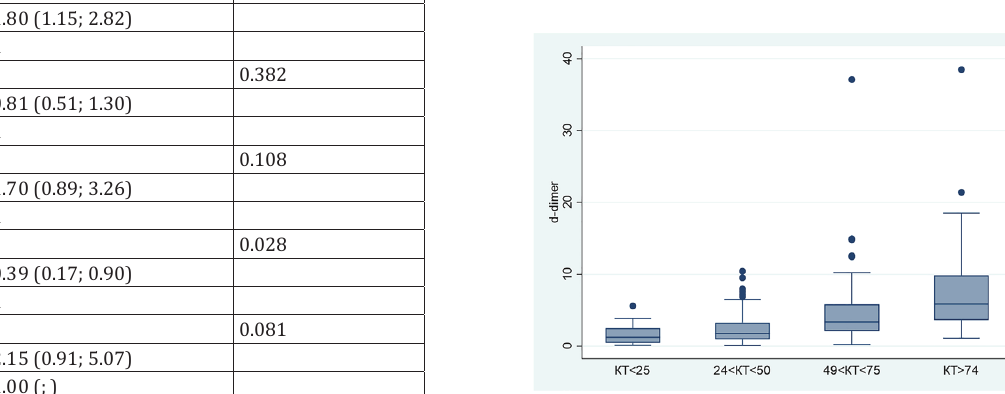
Figure 2 - Dependence of D-dimer and the degree of lung damage on CT